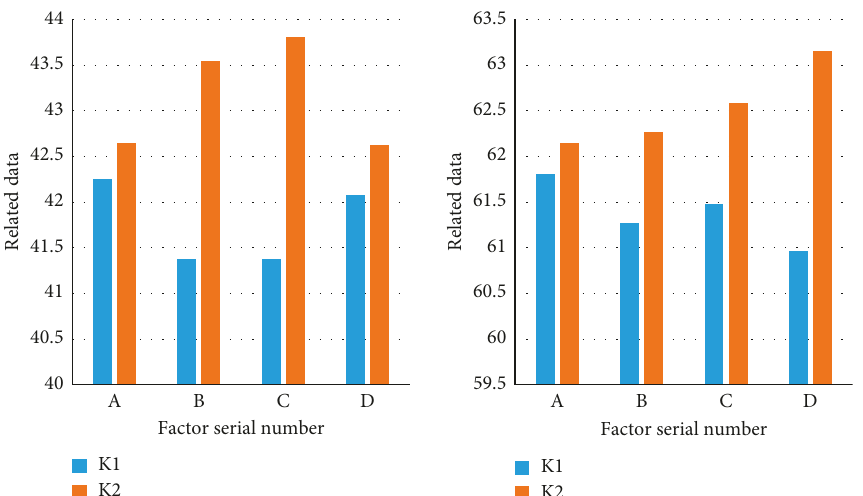
Figure 7: Fabric orthogonal experiment